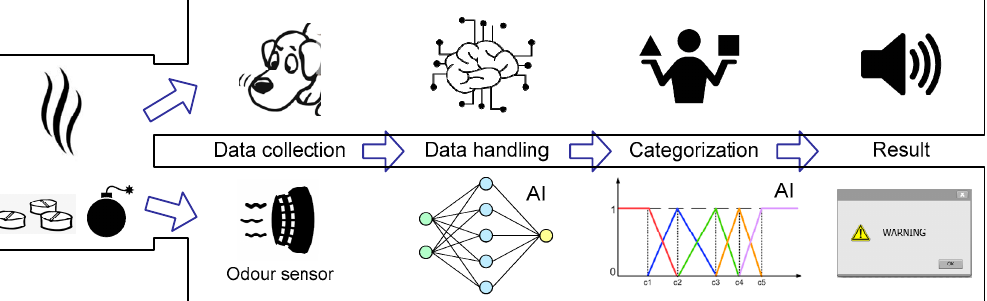
Figure 8. The typical odor recognition